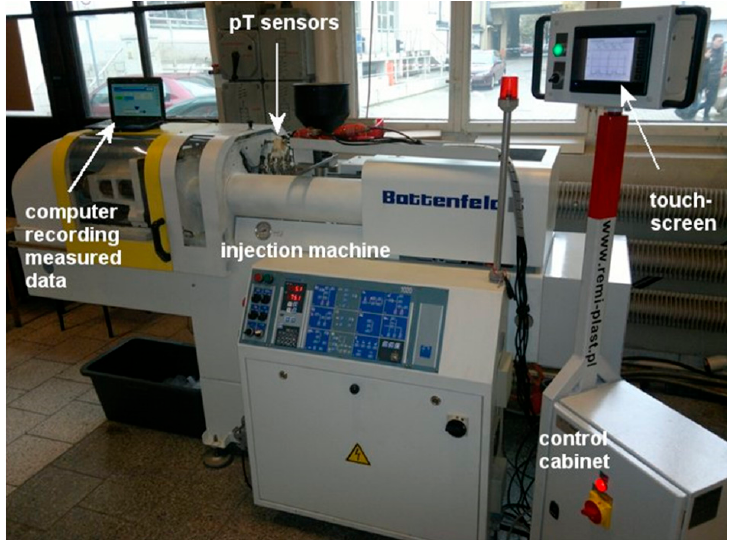
Figure 6. The test office for the plasticization process in the injection moulding.